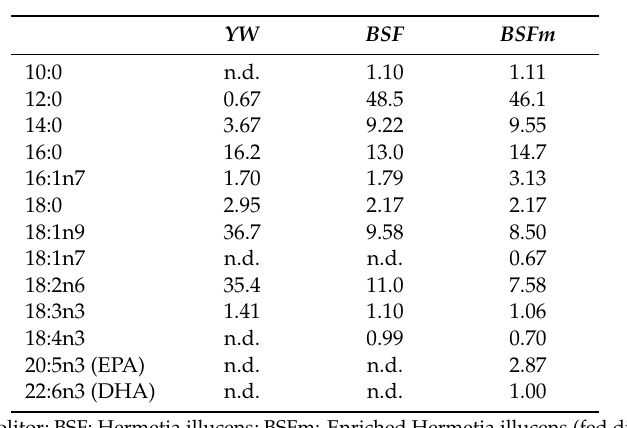
Table 6. Fatty acids profile from yellow mealworm meal, Black Soldier Fly and Black Soldier Fly enriched with n-3 LCPUFAS (g / 100 g total fatty